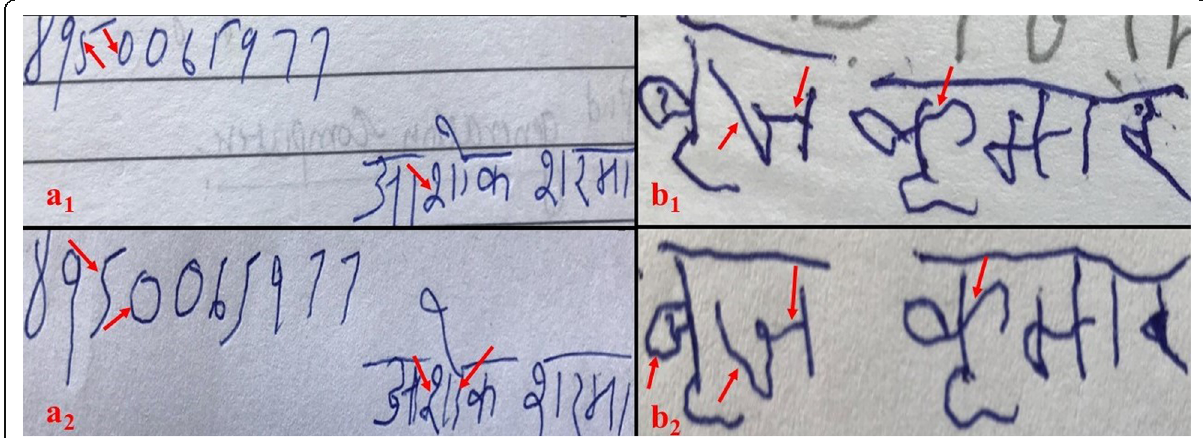
Fig. 2 Tremor. a 1 Absence of tremor in writing before onset of RA. a 2 Tremor in handwriting of RA patient. b 2 Artificial tremor observed at unnatural places in copied